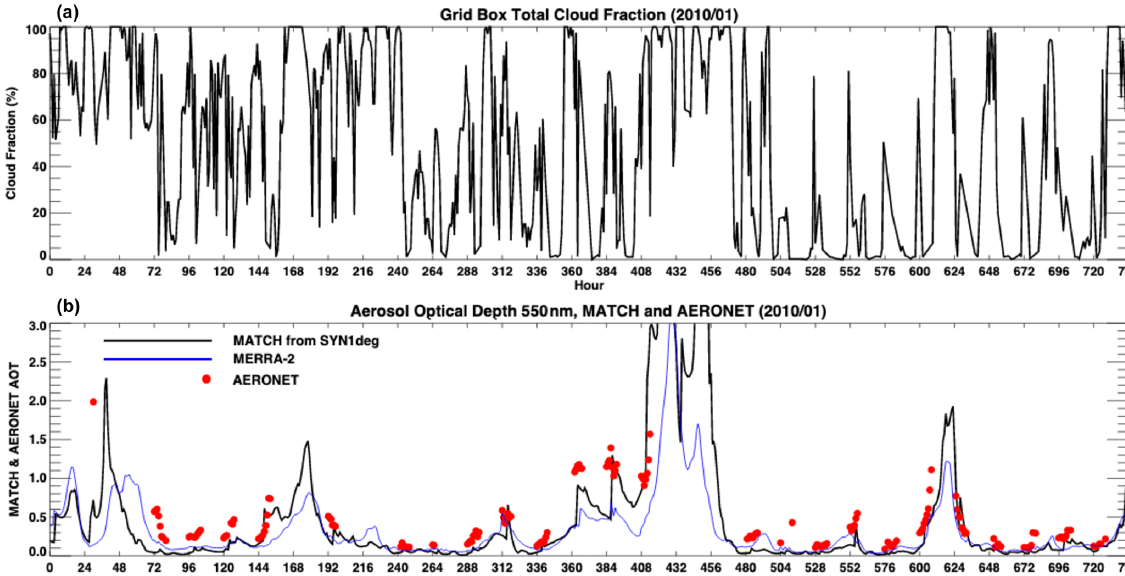
Figure 6. Hourly time series of the (a) grid box cloud fraction from the SYN1deg Edition 4.1 CERES product and (b) AOD. Results are from the grid box containing the AERONET Beijing (China) site. The black line represents MATCH, the blue line represents MERRA-2, and the red dots represent AERONET observations. MATCH and, to a lesser degree, MERRA-2 often have large increases in AOD when the cloud fraction nears 100%.